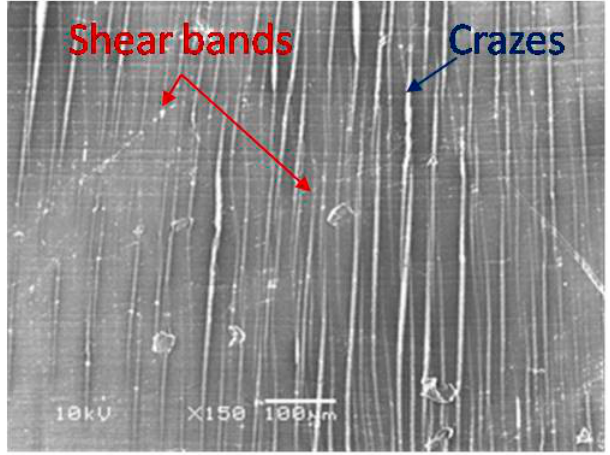
Figure 9. Simultaneous formation of crazes and shear bands.